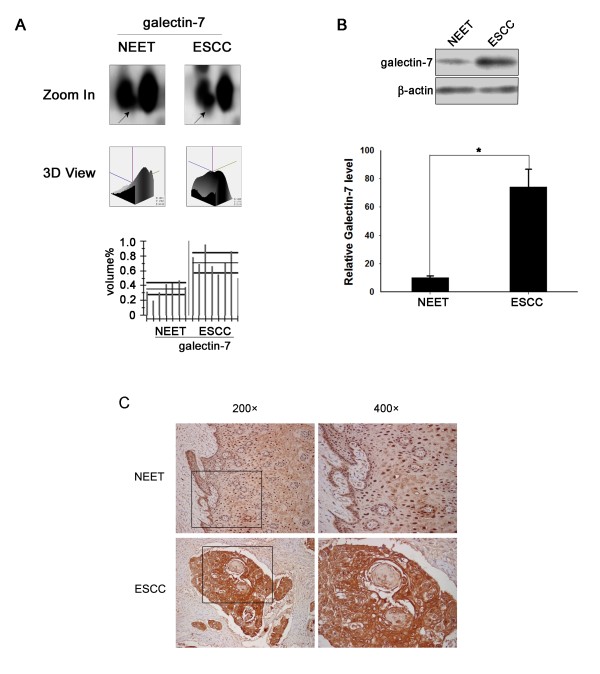
Expression of galectin-7 is up-regulated in ESCC tissues relative to NEET tissues. (A) The magnified comparison maps, quantified 3D views and statistical analyses of galectin-7 expression in NEET and ESCC samples. (B) Representative samples of ESCC and NEET were resolved on 10% polyacrylamide gels and immunoblotted with an anti-galectin-7 antibody and a β-actin antibody as a loading control. The intensity of each band was measured with GraphPad Prism 4.0 software, and relative galectin-7 protein levels between ESCC and NEET samples were normalized against those of β-actin. The expression of galectin-7 was increased in tumor tissues. The difference in galectin-7 expression between ESCC and NEET samples was assessed using Student's t-test (*P < 0.05) for unpaired values. (C) Immunohistochemical analysis of galectin-7 expression in ESCC. Galectin-7 displayed positive staining in ESCC samples that was much stronger than the staining in non-neoplastic tissue. In normal esophageal epithelial tissues, galectin-7 is localized primarily to the nucleus. Expression of galectin-7 was detected ubiquitously in the cytoplasm, nuclei and membranes of ESCC cells. Images in the left panel were taken under 200× magnification; the right panel images are 400× magnifications of the same sections depicted on the left.